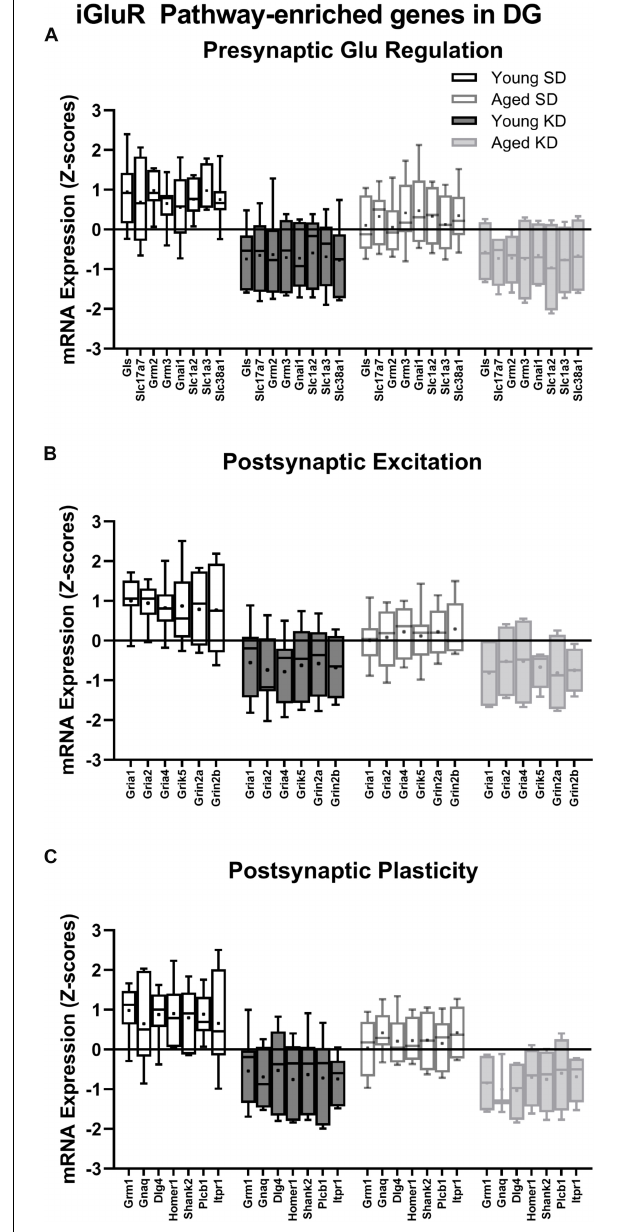
FIGURE 3 | Genes affected by diet in the dentate gyrus. The heat map represents mean z -scores of all genes that were significantly reduced (FDR q = 0.005 threshold) as a function of diet. Genes were categorized into biologically relevant processes, and experimental groups were ordered to reflect the main effect of diet. Yellow represents greater gene expression, whereas blue represents lower gene expression. Black represents no change.